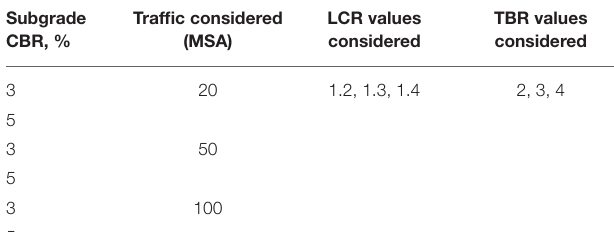
TABLE 1 | Scheme of pavement designs using LCR and TBR approaches.